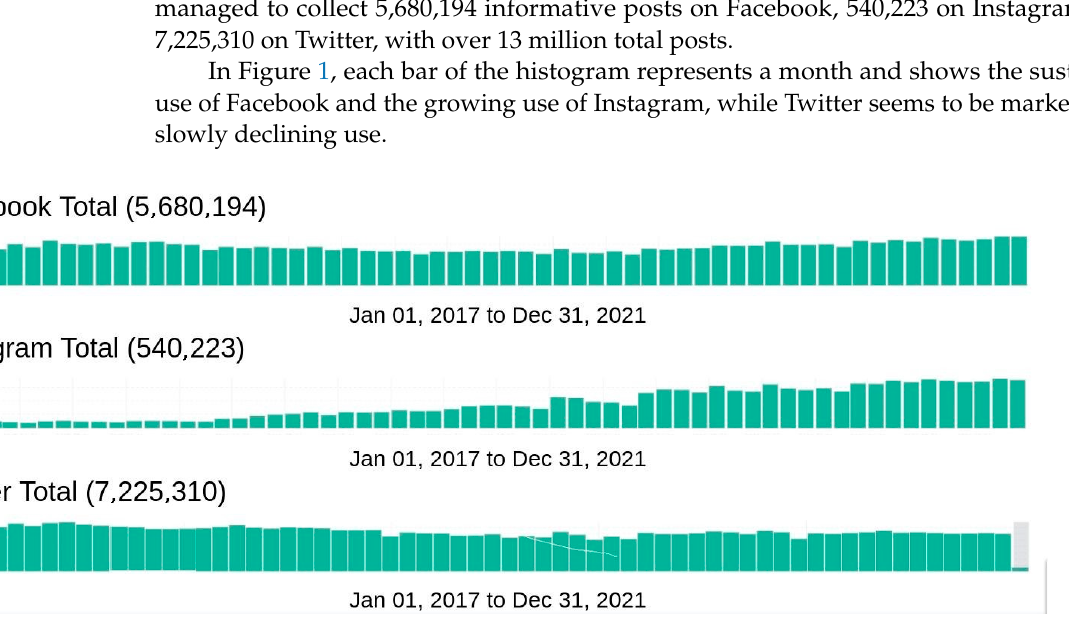
Figure 1. Total posts mined for each social network.